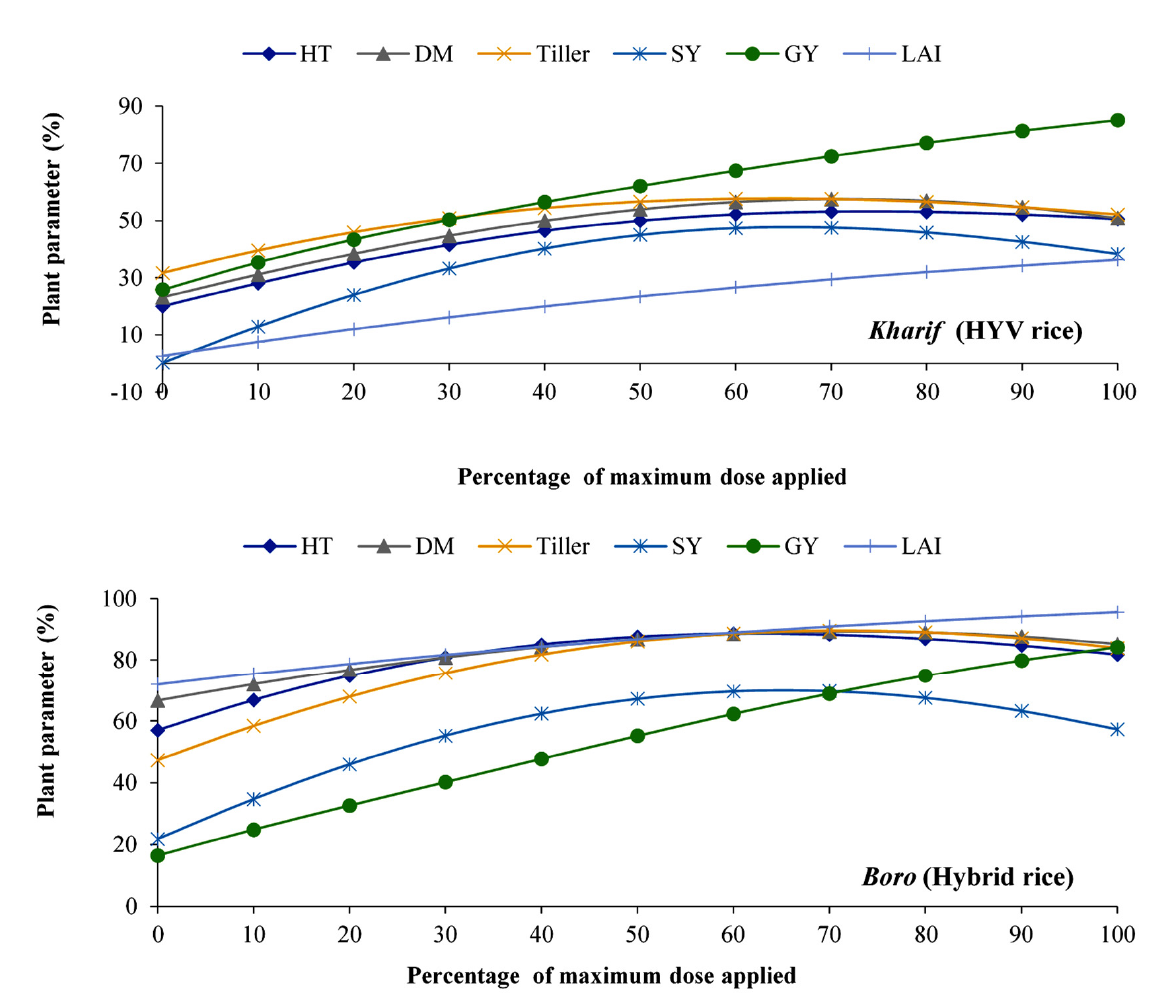
Figure 2. Effect of nitrogen on different plant parameters of kharif and boro rice. Notation: HT = plant height at 120 DAT (days after transplanting); DM = dry matter accumulation at 120 DAT; SY = straw yield; GY = grain yield; LAI = leaf area index at 60 DAT.